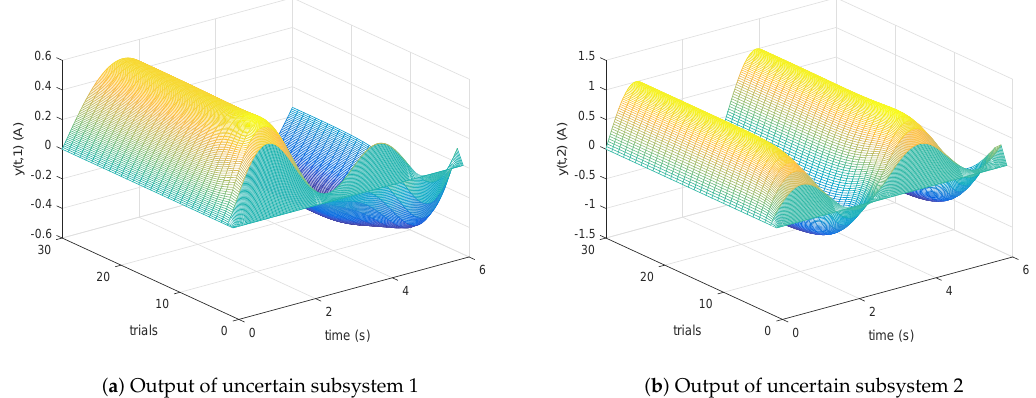
Figure 6. Outputs of uncertain subsystems 1 and 2.